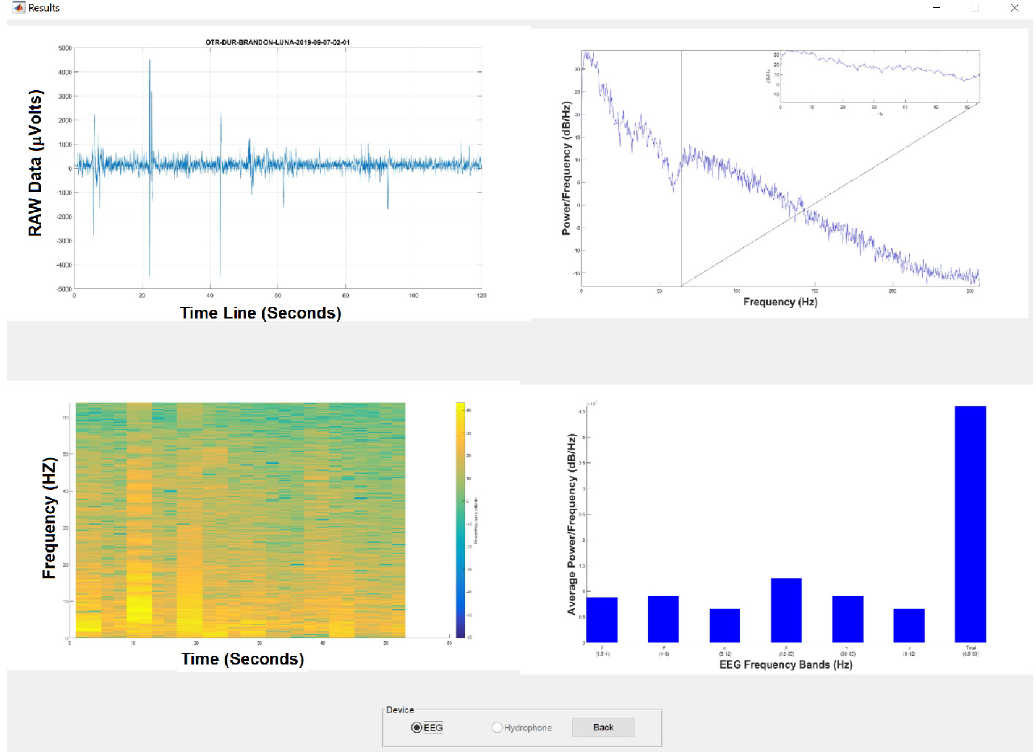
Figure 20. Results generated from the Analysis of a patient’s results for biomedical